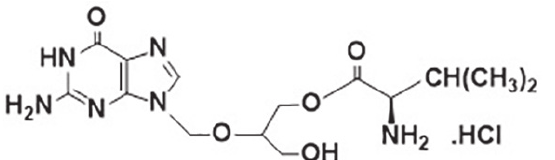
FIGURE 1 - Chemical structure of valganciclovir